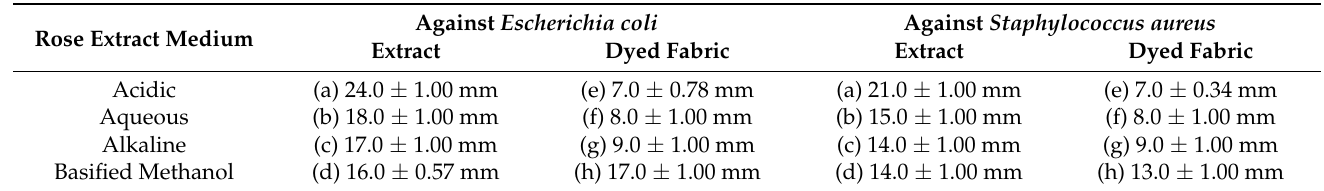
Table 1. Antibacterial activity of different rose extracts and their dyed fabrics against Escherichia coli and Staphylococcus aureus.